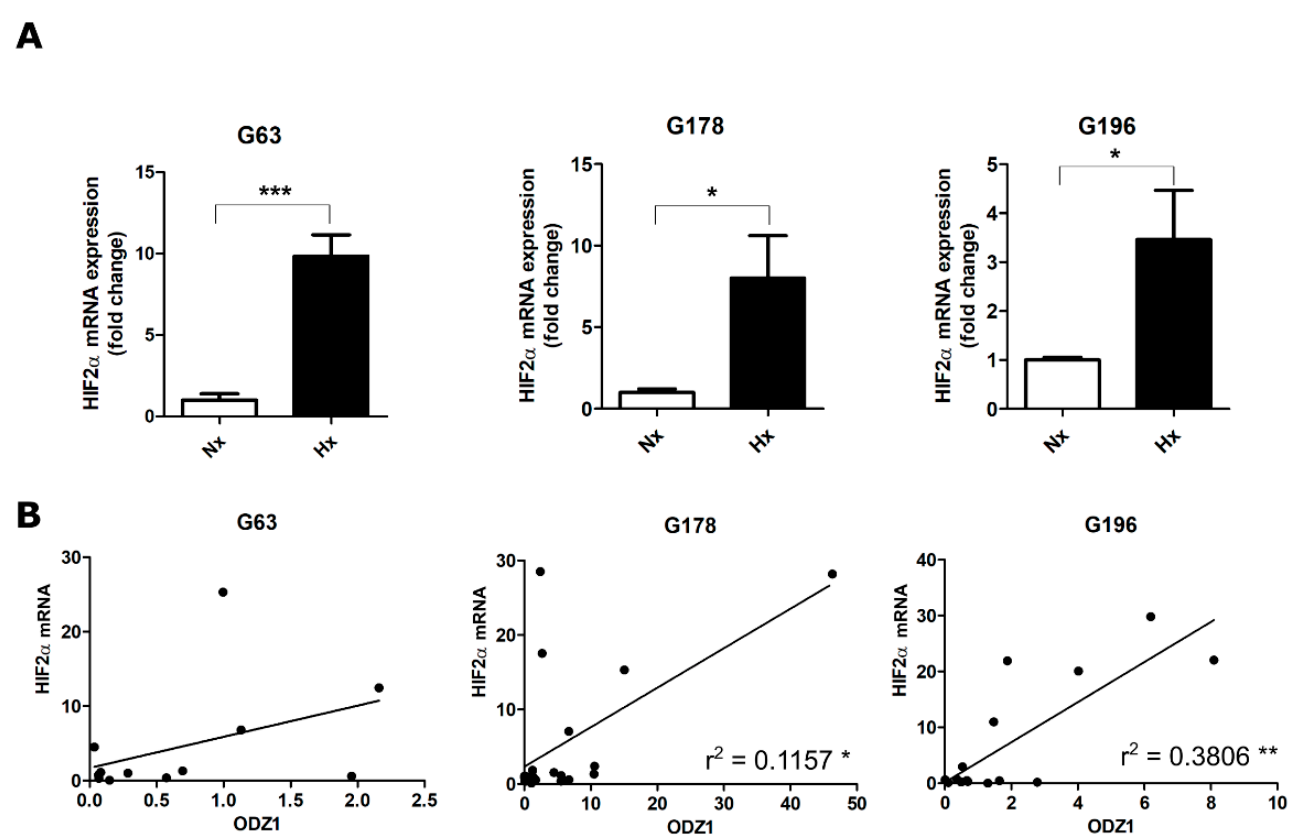
Figure 3. Expression of HIF2a mRNA correlates with ODZ1 mRNA levels. ( A ) GSC cell lines were cultured under hypoxia, and the expression of HIF2 α mRNA was analyzed by qPCR. Data were normalized to G6PD levels. * p < 0.05, ** p < 0.01, *** p < 0.001. Bars represent mean ± SEM of three independent experiments. ( B ) Correlation between ODZ1 mRNA and HIF2 α mRNA. Pearson’s co- efficient (r); p < 0.001.